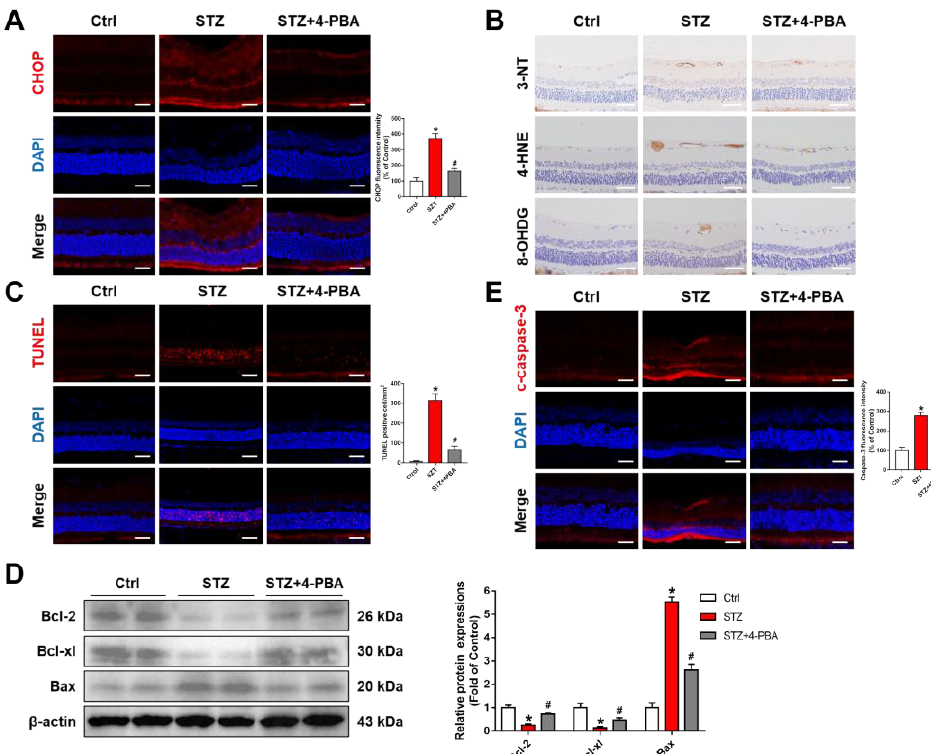
Figure 7. Inhibition of ERS ameliorated apoptosis in DR rats. ( A ) Immunofluorescence staining for CHOP (red) and DAPI (blue) was performed in rat retinal sections. Scale bars = 50 μm. ( B ) Immunohistochemistry analysis of 3-NT, 4-HNE, and 8-OHDG in retinas. Scale bars = 50 μm. ( C ) Apoptosis in retinal sections was appra ised with the TUNEL assay. Scale bars = 50 μm. ( D ) Western blot analysis for protein expressions of apoptosis-related proteins (Bax, Bcl-2, and Bcl-xl). ( E ) Cleaved caspase-3 (red) and DAPI (blue) in retinal sections were subjected to immunofluorescence staining. Scale bars = 50 μm. Data are presented as mean ± SD. * p < 0.05 vs. control group, # p < 0.05 vs. STZ group.